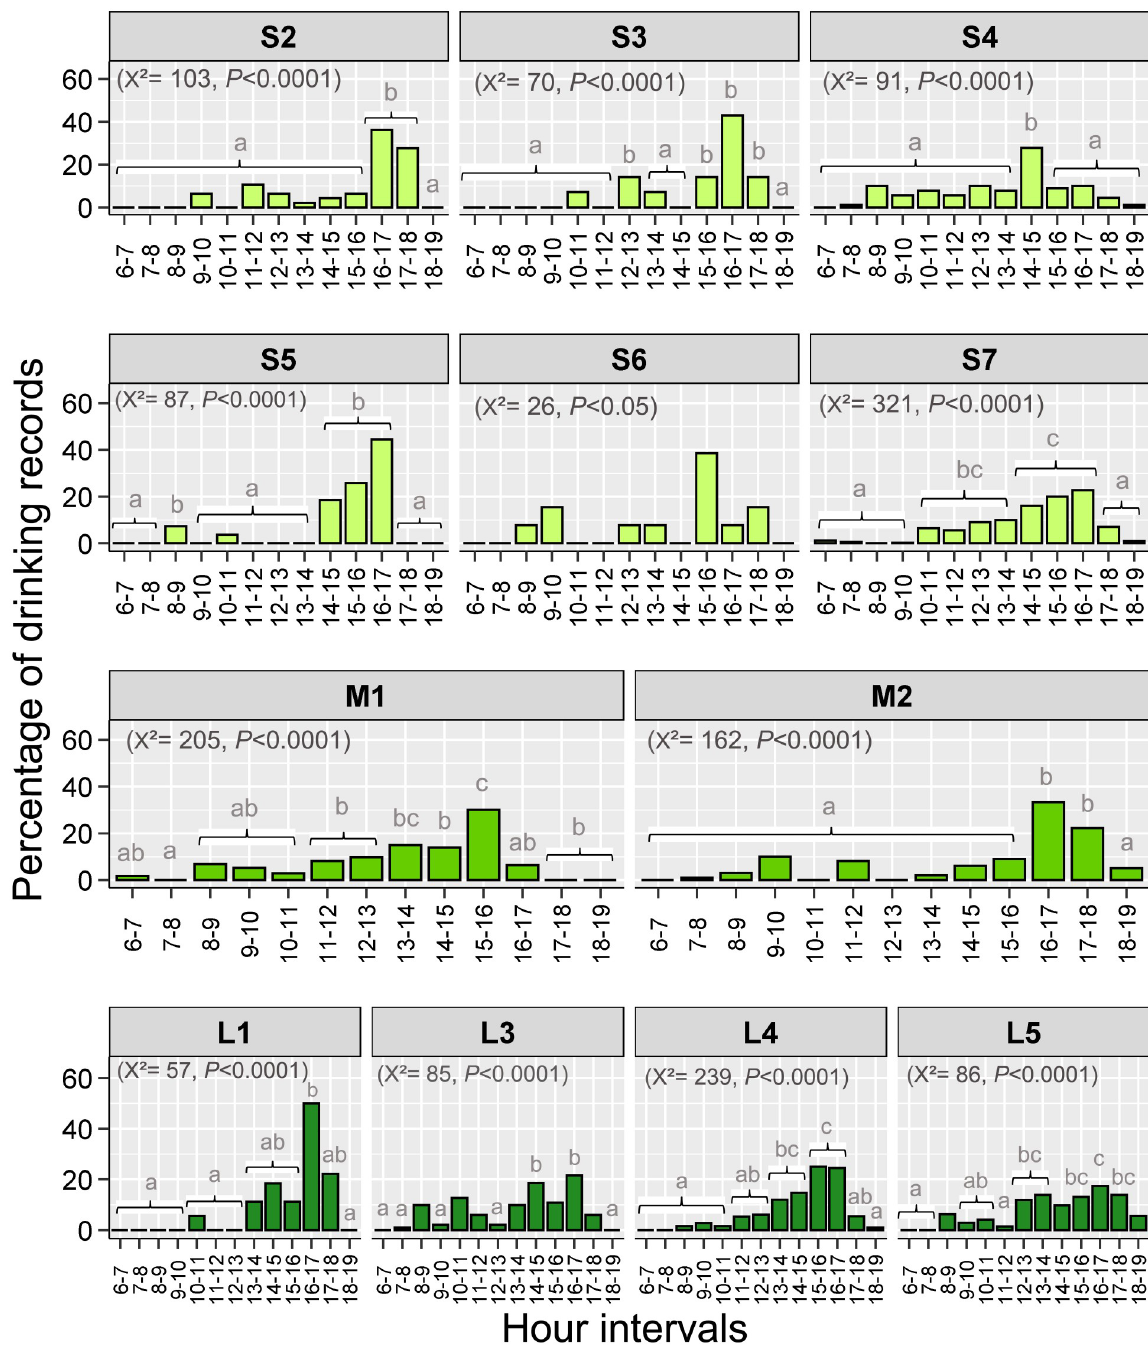
Fig 3. Variation in percentage of drinking records by brown howler monkeys during the day in small, medium, and large Atlantic Forest fragments. Different lower-case letters on the bars indicate significant differences after Bonferroni adjustment in P values. The absence of letters indicates that these hour intervals did not differ from the others. The number of degrees of freedom was 12 in all cases. Only fragments with > 10 drinking records were considered in this analysis.